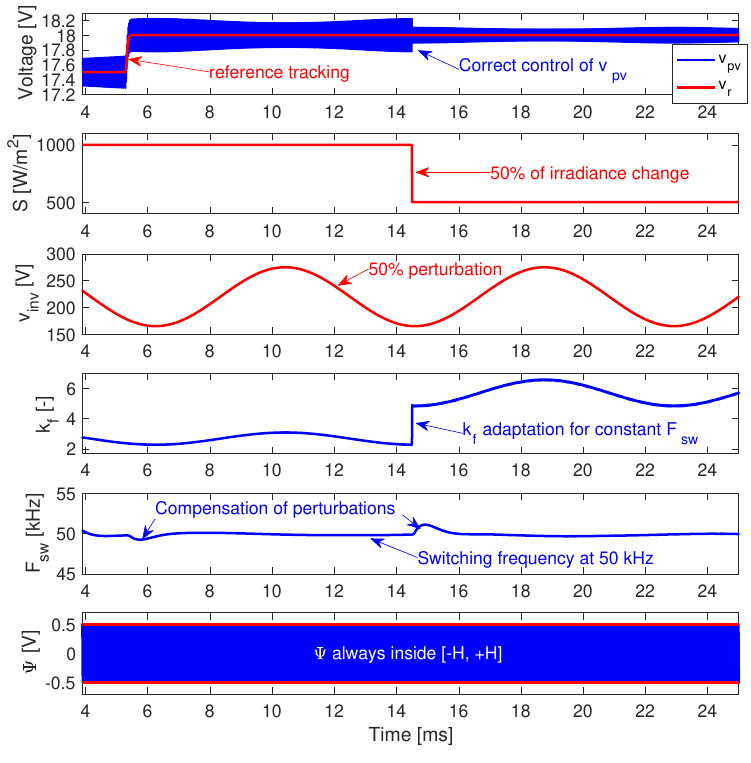
Figure 12. Performance of the SMC with multiple perturbation sources.